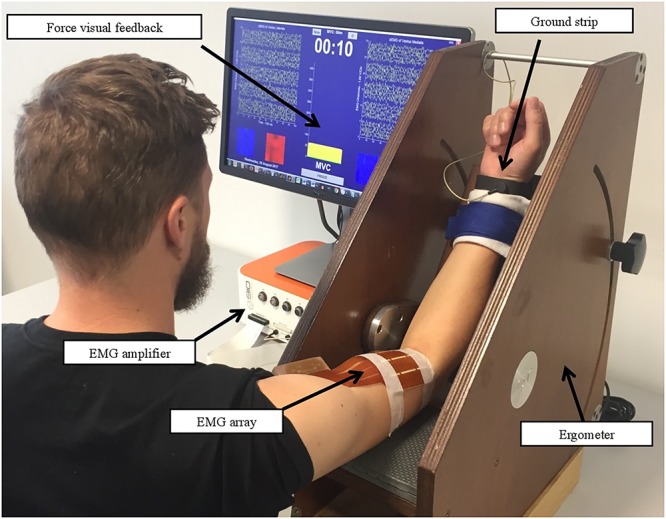
Setup of sEMG recording procedures. Written informed consent was obtained for the publication from the participant.